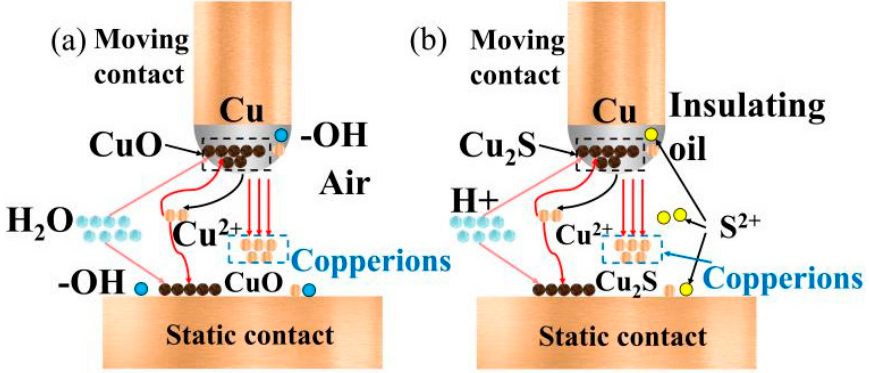
Figure 10. Formation mechanisms of ( a ) copper oxide in air and ( b ) cuprous sulfide in insulating oil.